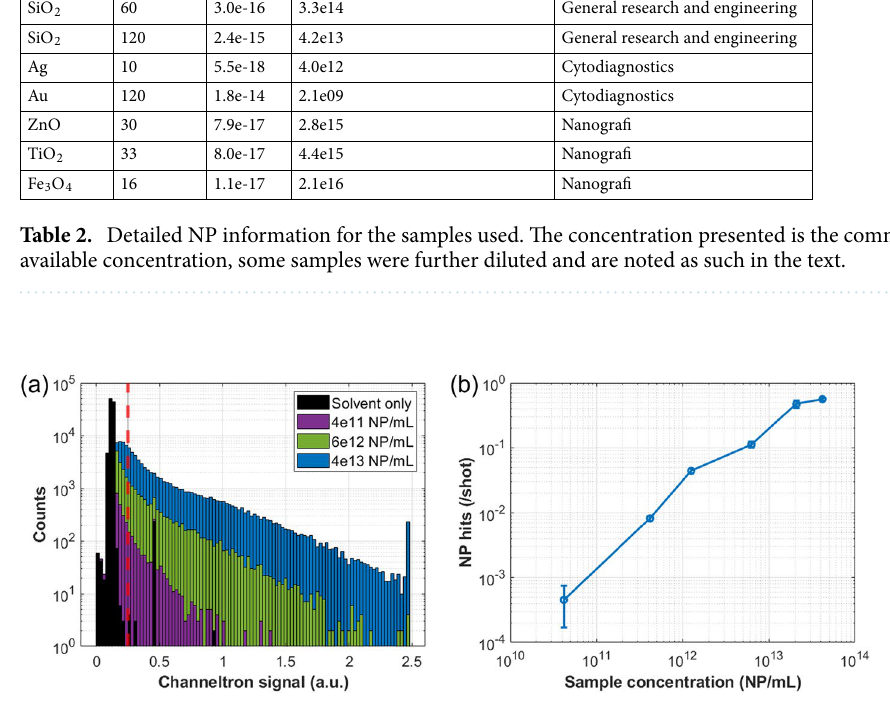
Figure 2. Integrated CEM signal for various suspension concentrations of 120 nm SiO 2 . ( a ) is a histogram of 1e5 laser shots for three NP concentrations as well as a solvent (water) only sample (i.e. 0 NP/mL). The dashed vertical red line indicates the threshold chosen to distinguish the presence or absence of a NP in the interaction region, CEM signals larger than the threshold are considered a NP hit. ( b ) plots the number of NP hits, normalized per laser shot, as a function of atomized (aqueous) NP sample concentration. Note the artifact present in the solvent only data set at a signal value of ∼ 0.5 in ( a ) is known to be due to transient noise in the CEM signal line. Error bars represent the standard deviation within the data set which becomes negligible at higher